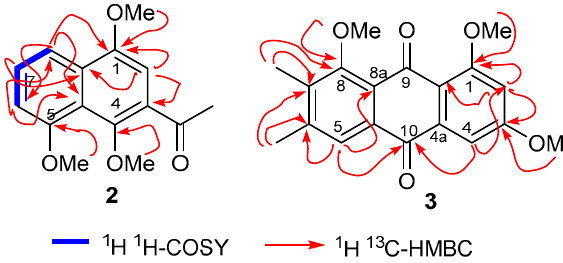
Figure 4. Key COSY and HMBC correlations of cichorin E ( 2 ) and F ( 3 ).